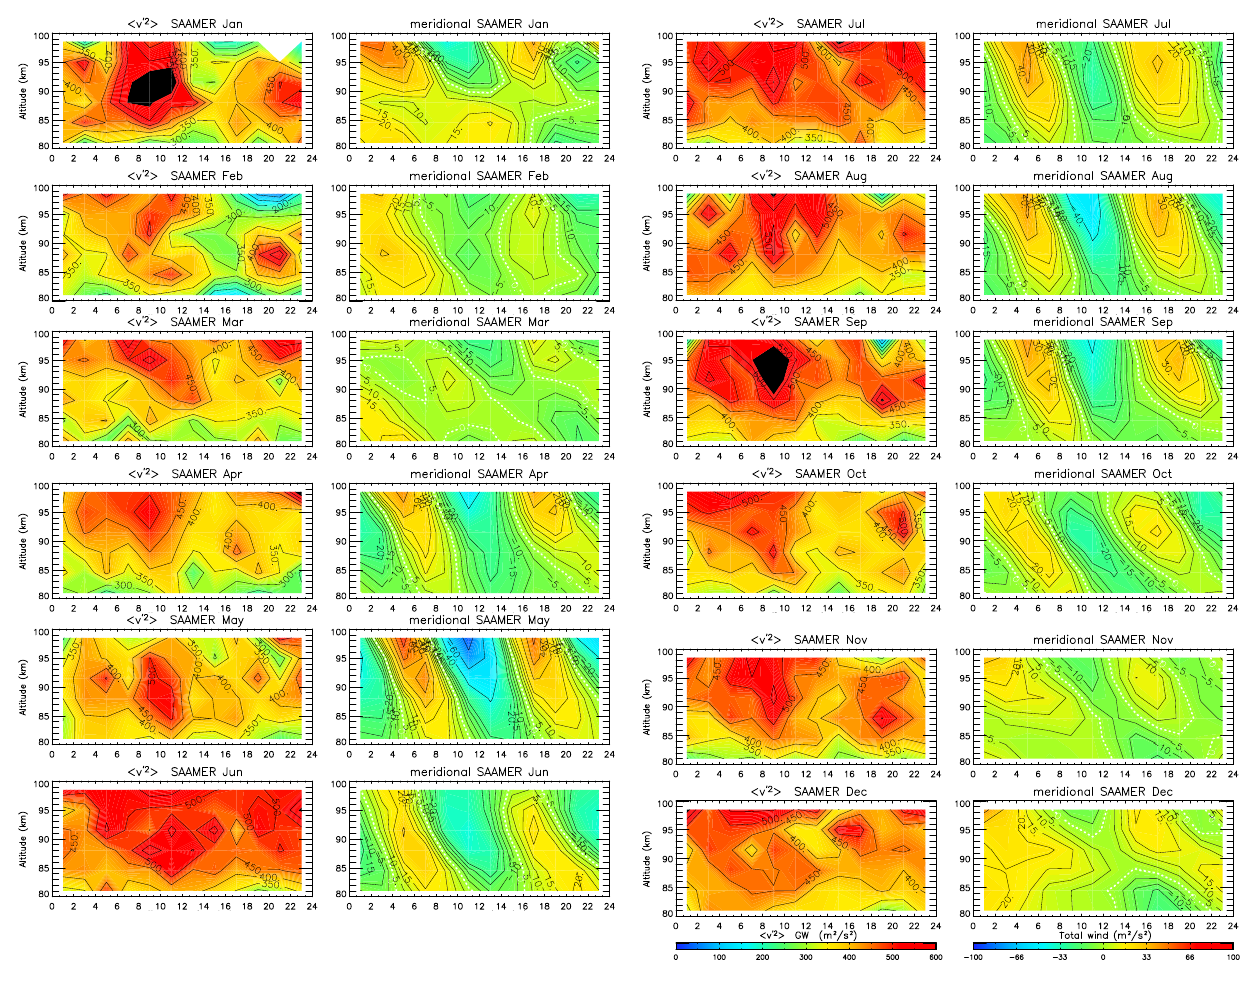
Fig. 12. The same as Fig. 11, but for the meridional